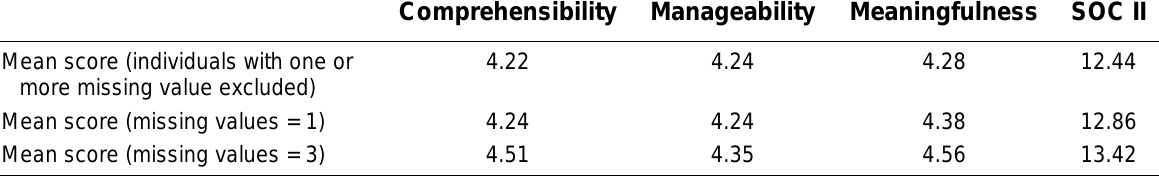
Mean Scores of Comprehensibility, Manageability, Meaningfulness, and SOC II